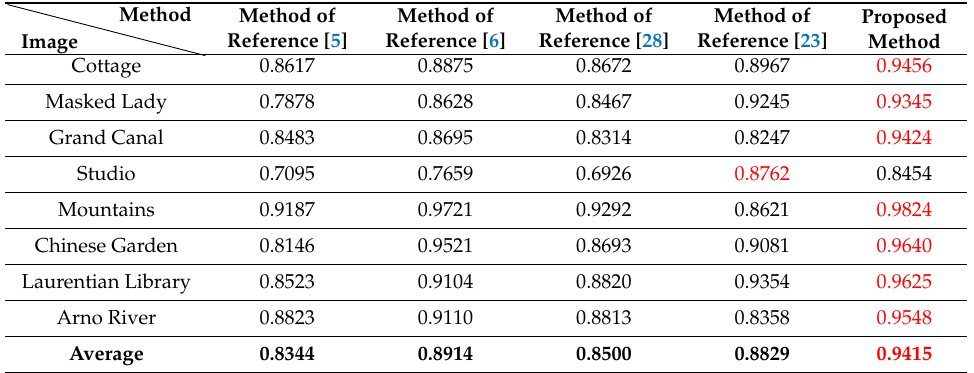
Table 4. Comparison of the five methods in terms of MEF-SSIM (multi-exposure fusion structural similarity)